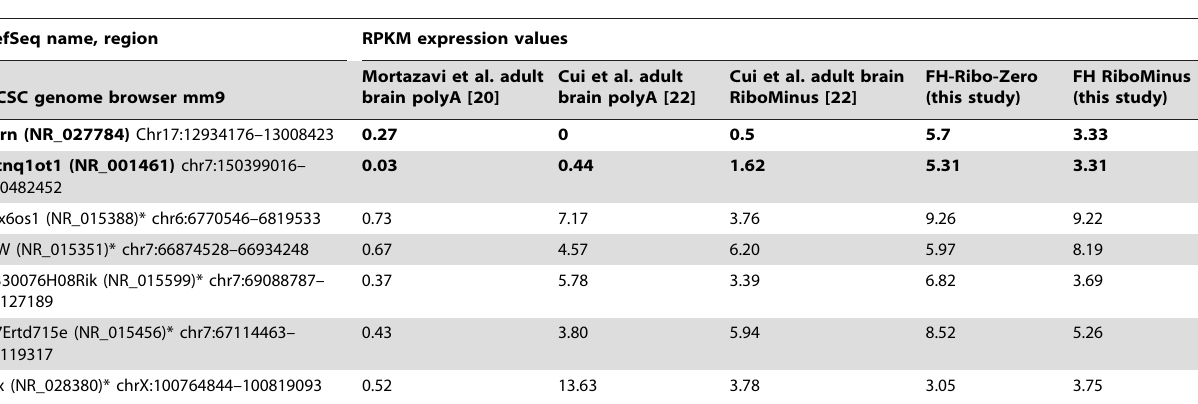
Table 1. Macro ncRNAs are more efficiently detected in RiboMinus and Ribo-Zero RNA-Seq.